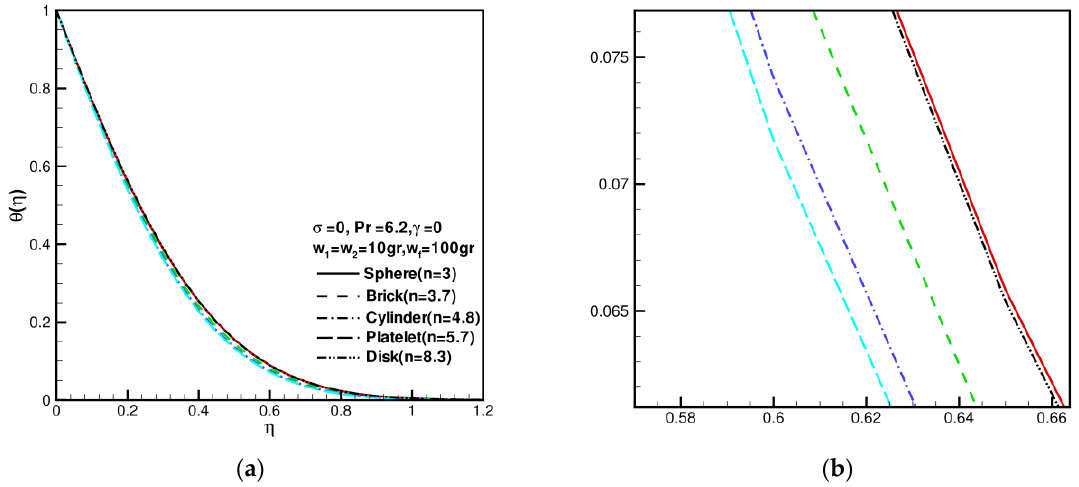
Figure 3. The dimensionless temperature distributions ( ) against shape factor n when w 1 = w 2 = 10 gr, w f = 100 gr, σ = 0, Pr = 6.2, and γ = 0: ( a ) the full picture of θ ( η ) ; ( b ) the partial enlargement picture of θ ( η ) .